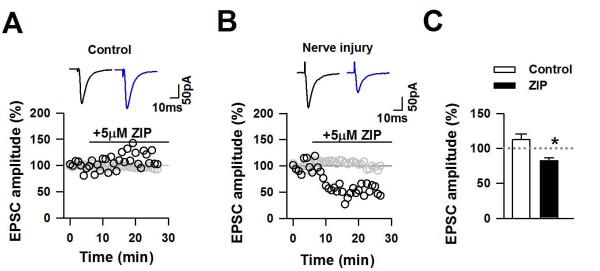
Increased NMDA NR2B receptor-mediated postsynaptic currents in adult ACC neurons is shown after inflammation. A, Confocal image of a pyramidal neuron in an adult ACC slice loaded with Lucifer yellow (top left). The arrow indicates the location of the neuron in the ACC slice (bottom left). Scale bar, 20 μm. When injected with current steps from -100 to 100 pA in 400 ms (bottom right), the neuron shown at the left fired repetitive action potentials with frequency adaptation (top right). A minority of neurons recorded (n = 4) showed the fast-spike properties (middle right). B, Current-voltage plot of the NMDA receptor EPSCs. The currents exhibited strong outward rectification and the reversal potential of the linear part was 4.4 ± 2.0 mV (n = 6 neurons/5 mice). Inset, NMDA receptor-mediated EPSCs recorded at holding potentials from -65 to 50 mV. Each trace represents the average of five consecutive recordings. C, A selective NR2B antagonist, Ro 25-6981, partially inhibited NMDA receptor-mediated EPSCs. The time course of changes in EPSC amplitude before and during the application of Ro 25-6981 (0.3 and 3 μM) and AP-5 (50 μM) in ACC neurons from both saline (control, Δ) and CFA-injected () mice is shown. Traces show the currents at different time points during application of drugs. Ro 25-6981 produced its maximal effect at 3 min after bath application, and a higher dose of Ro 25-6981 (3 μM) had no additional effects. The remaining currents can be totally blocked by AP-5 (50 μM). D, Summary data of the effects Ro 25-6981 (0.3 and 3 μM) in ACC neurons of control (saline-injected) and CFA-injected mice. Ro 25-6981 produced significantly greater inhibitory effects on NMDA receptor-mediated EPSCs in ACC neurons in CFA-injected mice (n = 9 neurons/8 mice) than those in control adult mice (n = 8 neurons/7 mice). AP-5 (50 μM) completely blocked the currents, confirming the currents are mediated NMDA receptors (n = 5 slices/5 mice). The double asterisks indicate significant difference from control, and the double daggers indicate significant difference from control NMDA receptor-mediated EPSCs. Error bars represent SEM (from Reference 24).